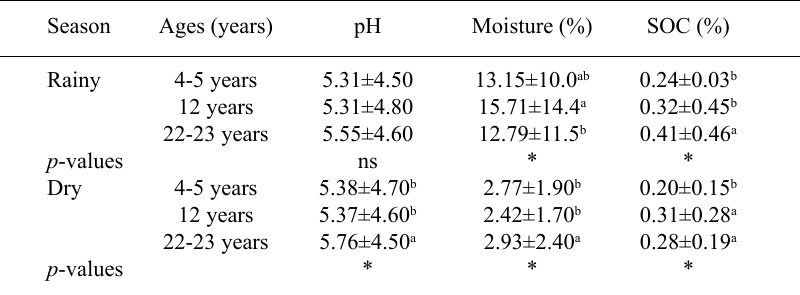
Table 2. Soil physical and chemical properties